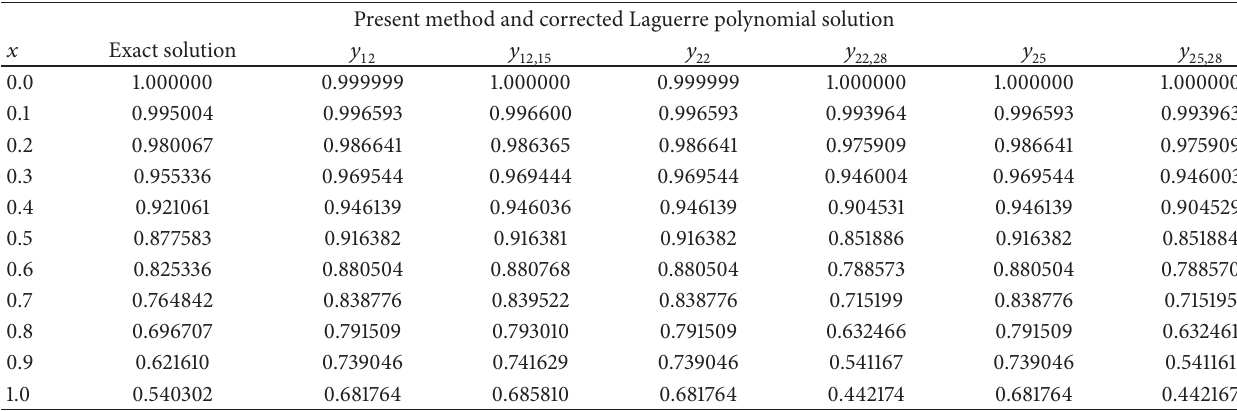
Table 6: Numerical solution of Example 7 for different 𝑁 values.